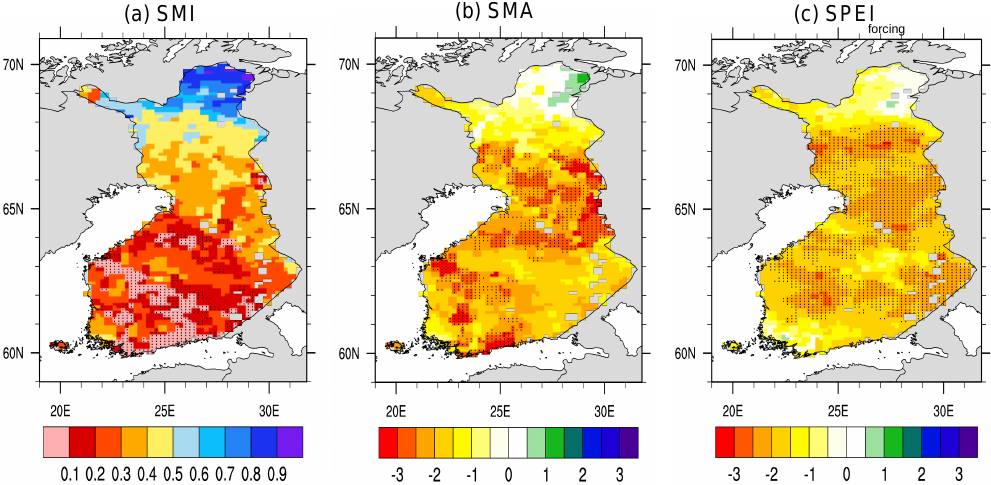
Figure 7. The (a) SMI, (b) SMA, and (c) SPEI forcing in the driest 28-day period of southern Finland in 2006. The dotted areas are under the derived thresholds for EDF. The uncovered grid boxes (grey cells) in Finland represent inland lakes.